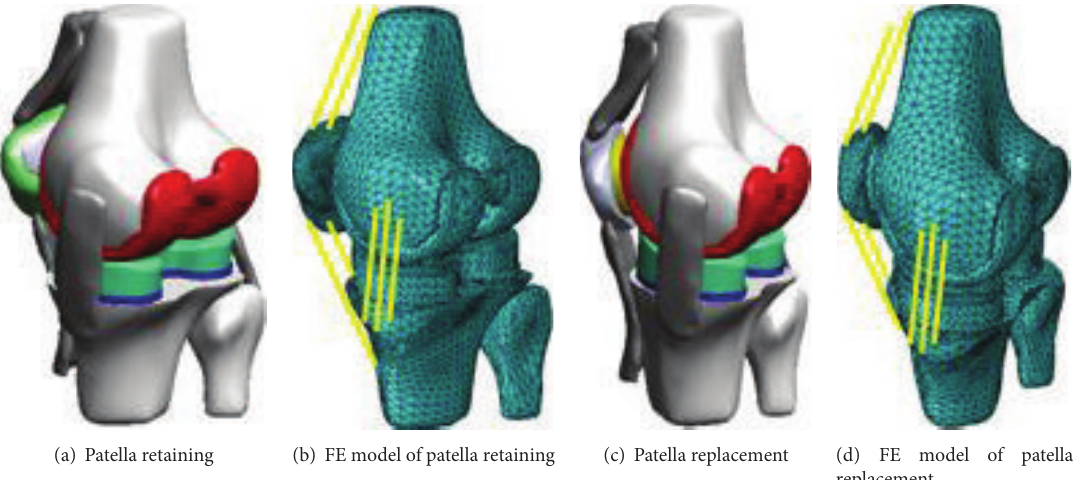
Figure 1: 3D and FE model following TKA with prosthesis.